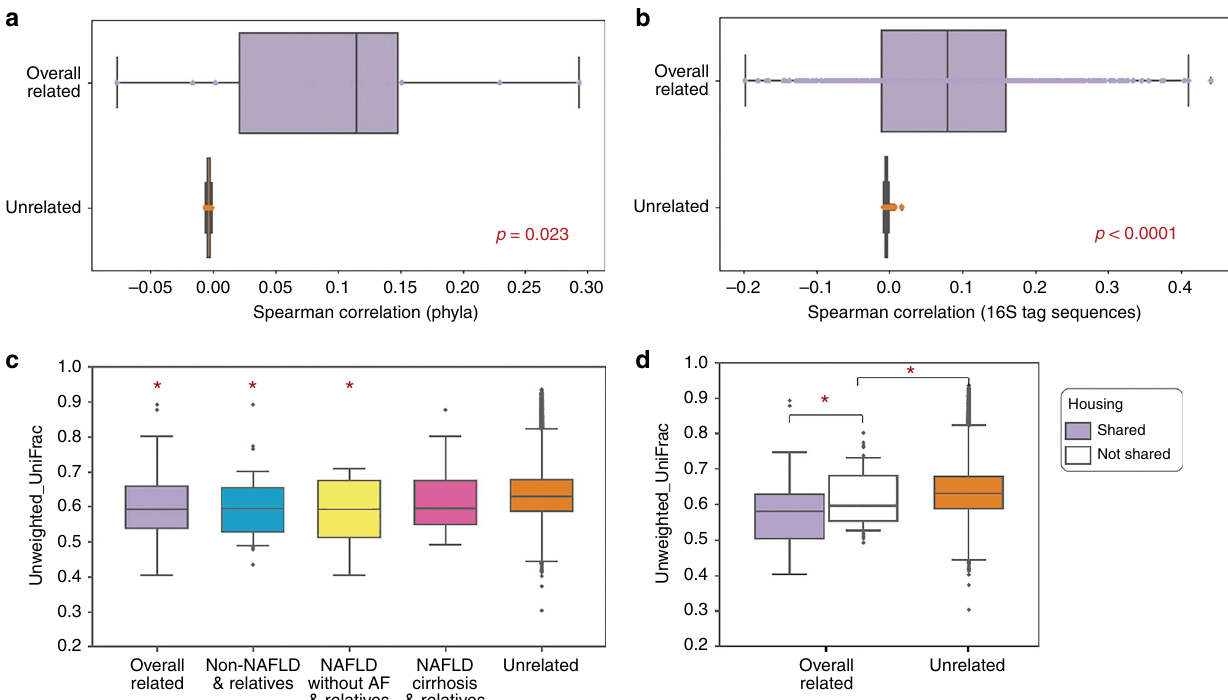
Fig. 1 Familial association and shared microbiome among relatives is driven by shared housing. Distribution of spearman correlation coef fi cients between relatives in purple ( n = 86) and unrelated pairs in orange ( n = 18232) in the familial cohort, plotted for each phyla ( a ) and 16S tag sequences ( b ). The box plots show the quartiles and whiskers show the rest of the distribution (1.5 inter-quartile range) and the center line corresponds to the median. This analysis was done after fi ltering rare 16S sequences to avoid spurious correlations due to sparsity (total abundance <10E-6 across all samples in each disease group). The correlation among related individuals was signi fi cantly higher at both phylum ( p = 0.023) and 16S tag sequences ( p = 2.4E-41) levels. Similar plot showing the distribution of unweighted UniFrac distances between related in purple and unrelated pairs strati fi ed by disease status ( c ). The beta-diversity was signi fi cantly lower among related individuals ( p = 3.22E-05), non-NAFLD controls and relative in blue ( n = 38 pairs) ( p = 0.0011) and probands with NAFLD without AF and relatives in yellow ( n = 15) ( p = 0.0156) when compared to the same among unrelated pairs in orange, while the difference between NALFD-cirrhosis patients and relatives in pink ( n = 33) and unrelated pairs in orange was not statistically signi fi cant ( p > 0.1). When strati fi ed by shared housing ( d ), beta-diversity was signi fi cantly lower among related individuals sharing a house in purple ( n = 35 pairs) ( p = 0.0455). Additionally, related individuals not sharing a house in white ( n = 51 pairs) had signi fi cantly lower beta-diversity compared to unrelated pairs in orange ( p = 0.028). All p value were determined by two-sided Kruskal-Wallis test. * p value < 0.05. Source data are provided as a Source Data fi